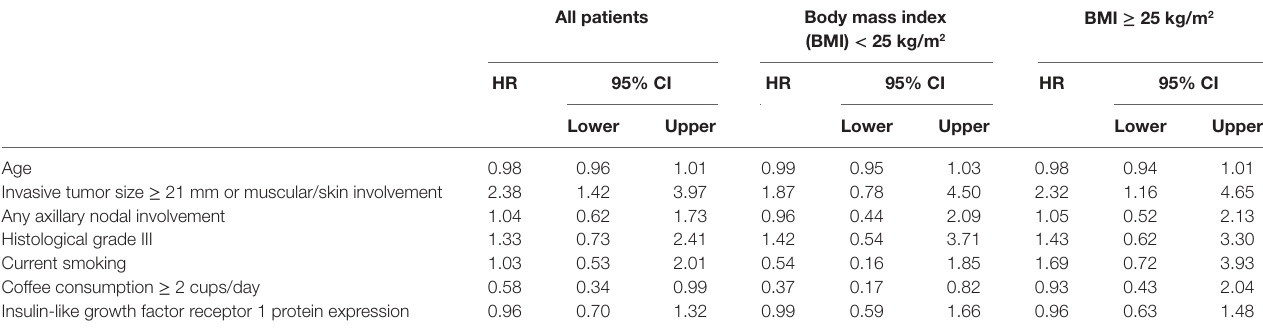
TaBle 3 | Multivariable analysis of risk of breast cancer events in tamoxifen-treated patients with ER + tumors ( n = 548).